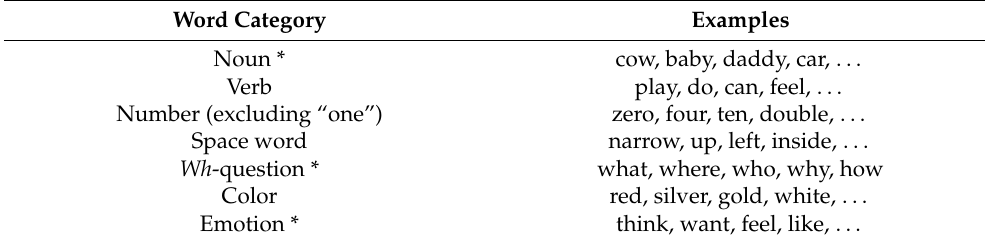
Table 2. Examples of word categories coded for language quality comparison. Word Category Examples Noun * cow, baby, daddy, car, . . . Verb play, do, can, feel, . . . Number (excluding “one”) zero, four, ten, double, . . . Space word narrow, up, left, inside, . . . Wh -question * what, where, who, why, how Color red, silver, gold, white, . . . Emotion * think, want, feel, like, . .